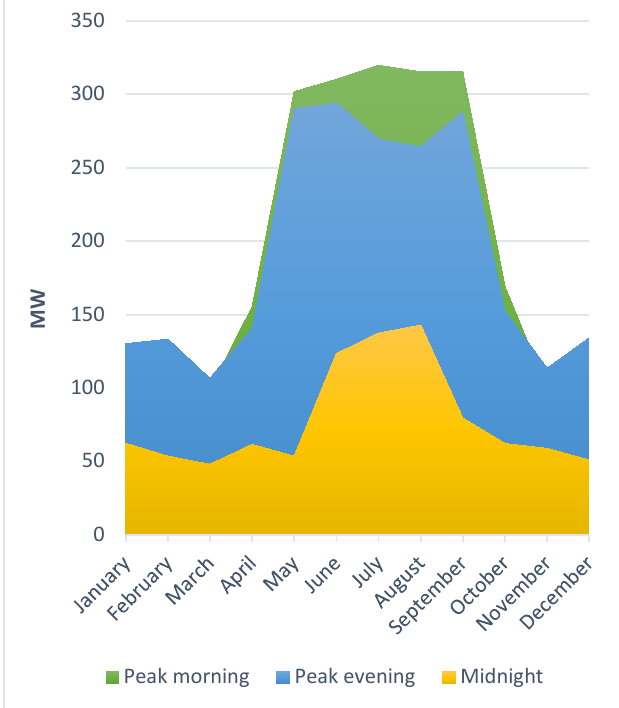
Figure 10. Annual evolution in demand for